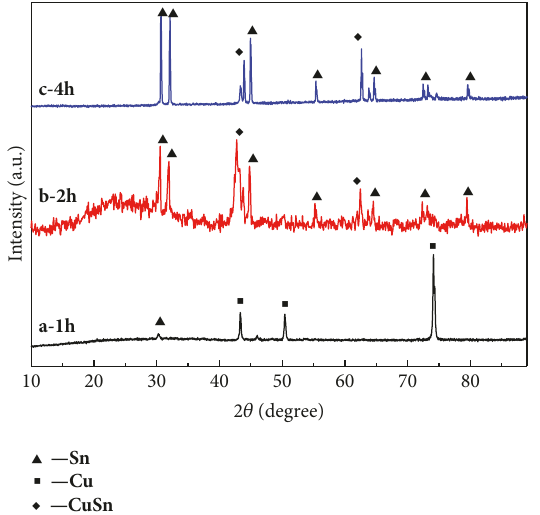
Figure 8: XRD patterns of tin deposits obtained from the [Bmim]HSO 4 /H 2 O mixture (30% H 2 O, v/v) solution containing 40mM SnO at − 0.6 V and 353K for different deposition time: (a) 1h, (b) 2h, and (c) 4 h.